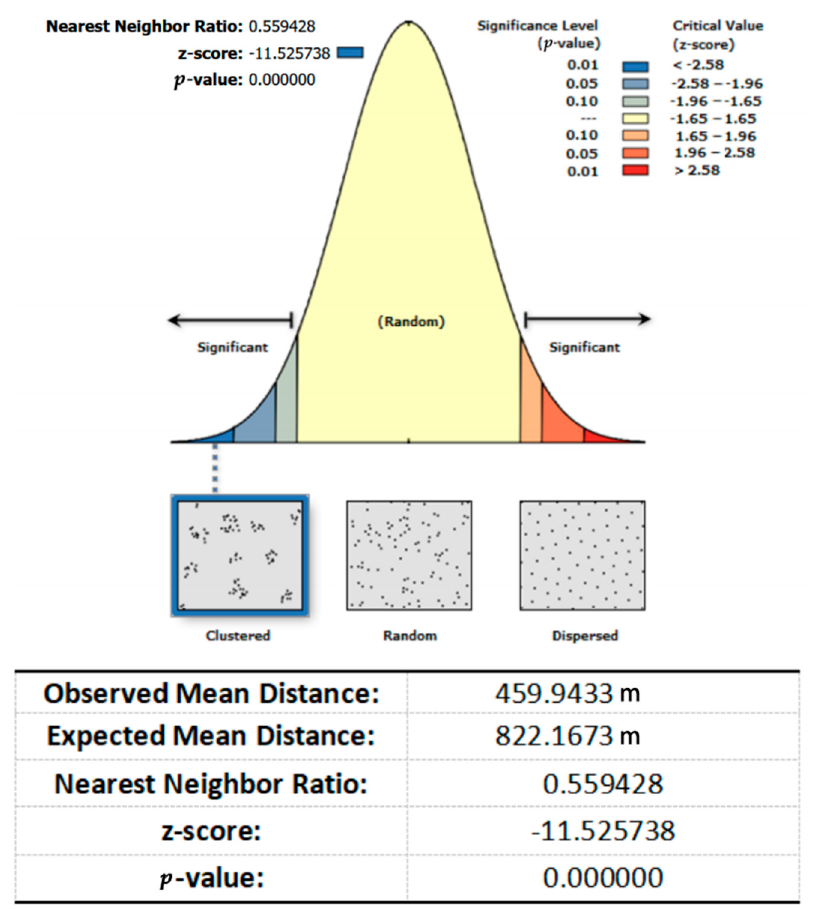
Figure 3. Nearest neighbor result